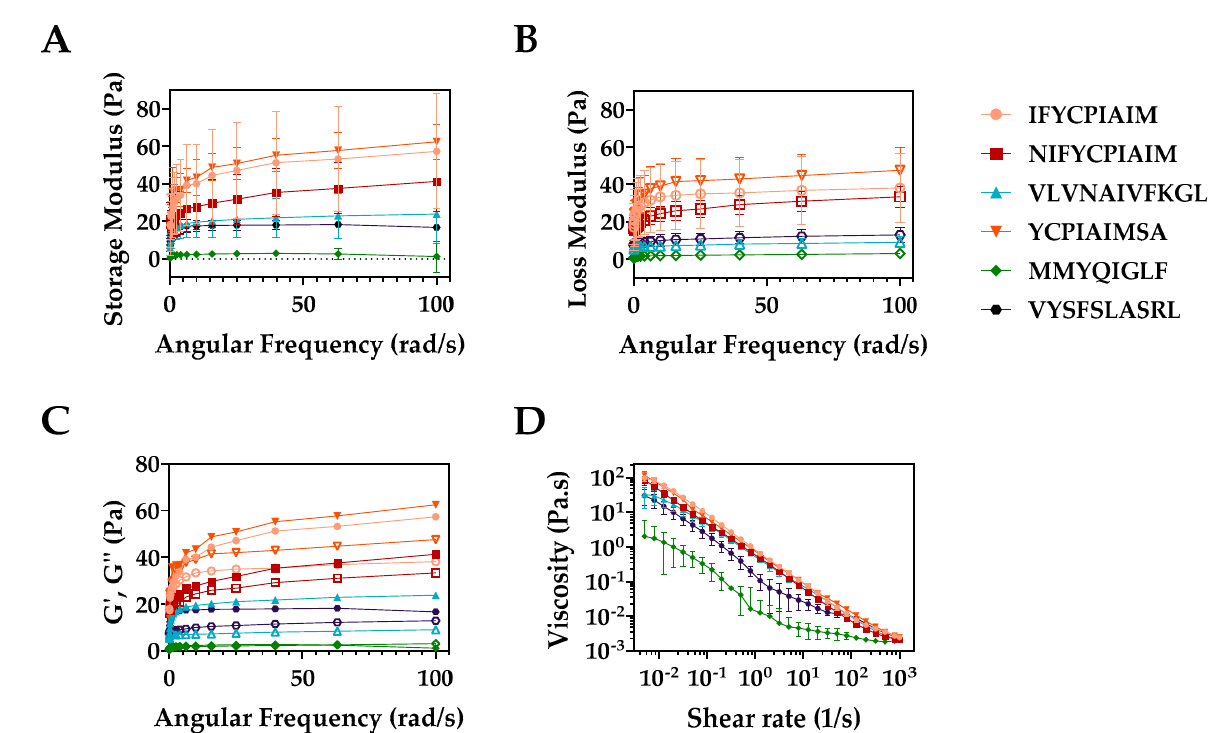
Figure 5. Biomechanical properties of ovalbumin-derived peptide self-assembly showing ( A ) the storage modulus (G (cid:48) ), ( B ) loss modulus (G (cid:48)(cid:48) ), and ( C ) both as a function of angular frequency, where G (cid:48) is the filled shapes and G (cid:48)(cid:48) is the corresponding open shapes (standard error bars removed for ease of viewing). ( D ) Flow sweep experiment of viscosity as a function of shear rate response of the self-assembling ovalbumin-derived peptides.